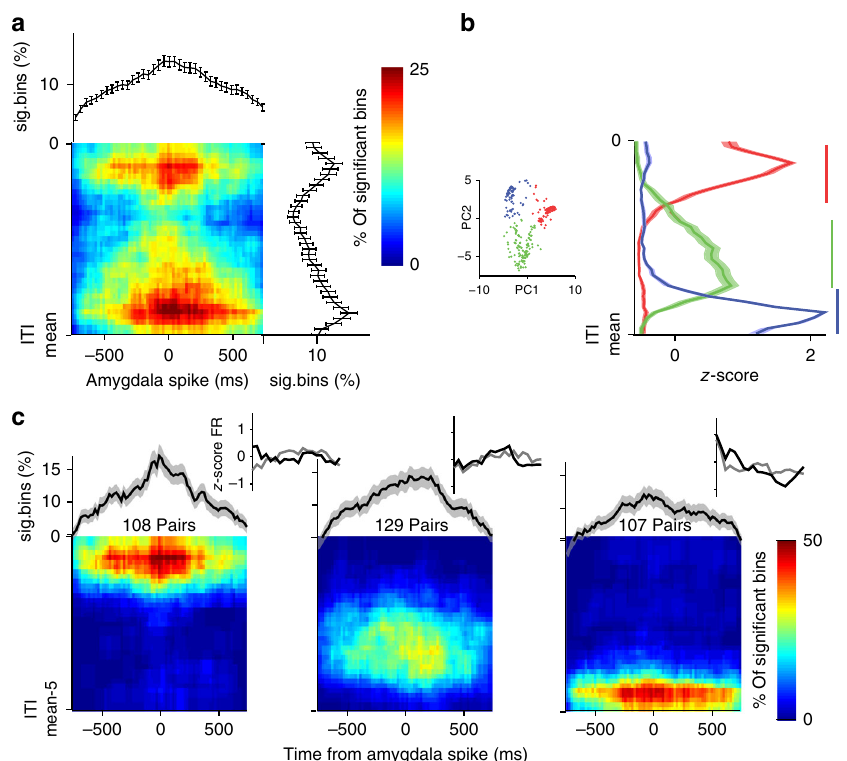
Fig. 7 Amygdala-dACC pairwise-correlations peak at speci fi c times during the ITI. a Cross-correlations were computed between simultaneously recorded amygdala-dACC neurons in sliding 3-s segments of the ITI. CCs were compared to shuf fl es to exclude changes resulting from covariations within and across ITIs (methods and Supplementary Fig. 3). Shown is the map of % signi fi cant bins from all pairs, for the duration of the ITI ( y -axis, top to bottom) and triggered on amygdala spike ( x -axis, time zero). Upper plot shows the average (marginal) CC over the whole ITI, and right plot shows the average (marginal) percentage of sig. bins along the ITI. b Shapes of individual CCs were clustered (inset, k -means on principal components after z -score), and the average shape for each cluster is presented; revealing two distinct times of CC peaks — early (red) and late (blue) in the ITI, and a third (green) lower widespread modulation. Horizontal colored bars indicate regions with signi fi cant synchronization ( p < 0.01; t -tests). c Same as in a presented separately for each cluster found in b . Pairs with early (left) and late (right) CC were more focused in time during the ITI and exhibited stronger synchronization. Data presented as mean ± S.E.M. n = 344 pairs of amygdala-dACC